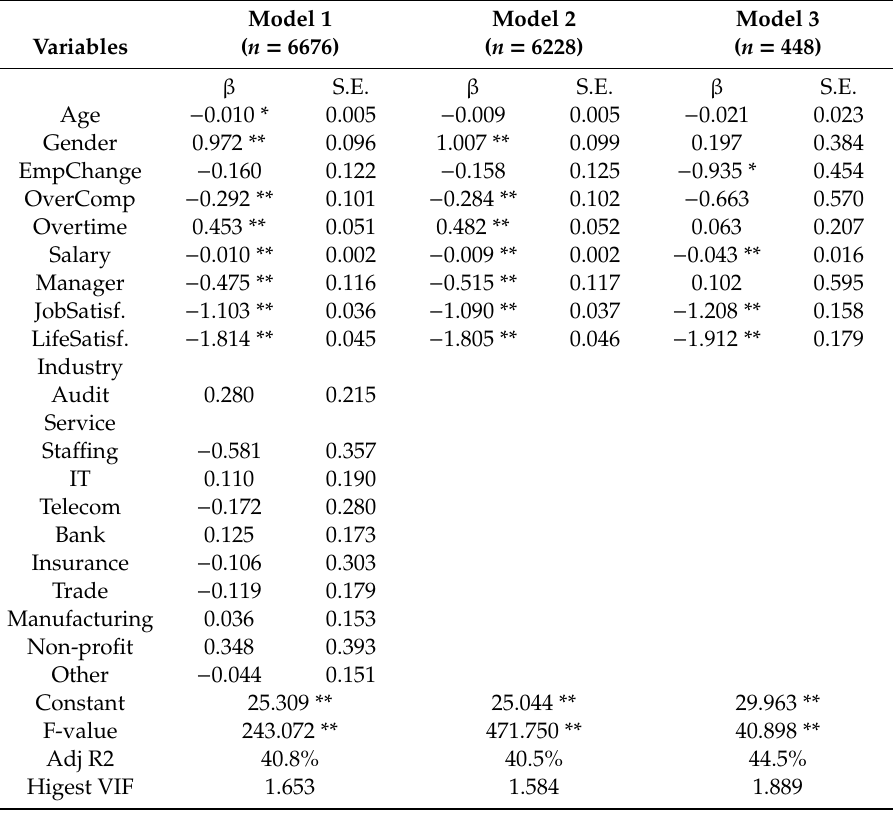
Table 3. Regression models (Dependent variable: